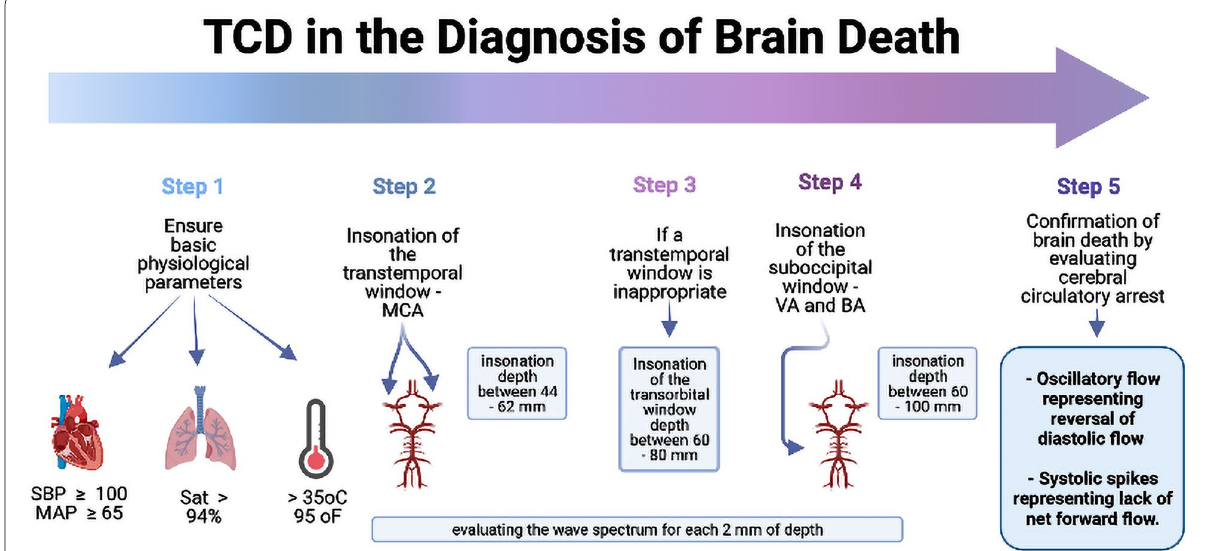
Fig. 7 A step-by-step algorithm for TCD use in the diagnosis of brain death. SBP, systolic blood pressure; MAP mean arterial pressure; Sat, saturation of oxygen; MCA, middle cerebral artery; VA, vertebral artery; BA, basilar